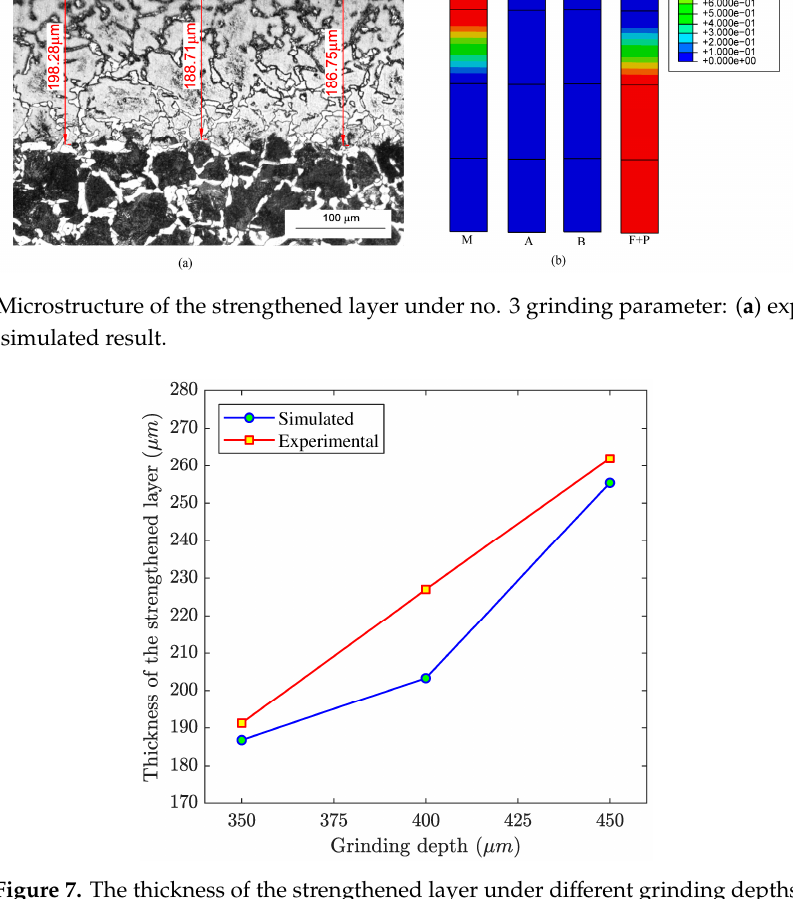
Figure 7. The thickness of the strengthened layer under different grinding depths.